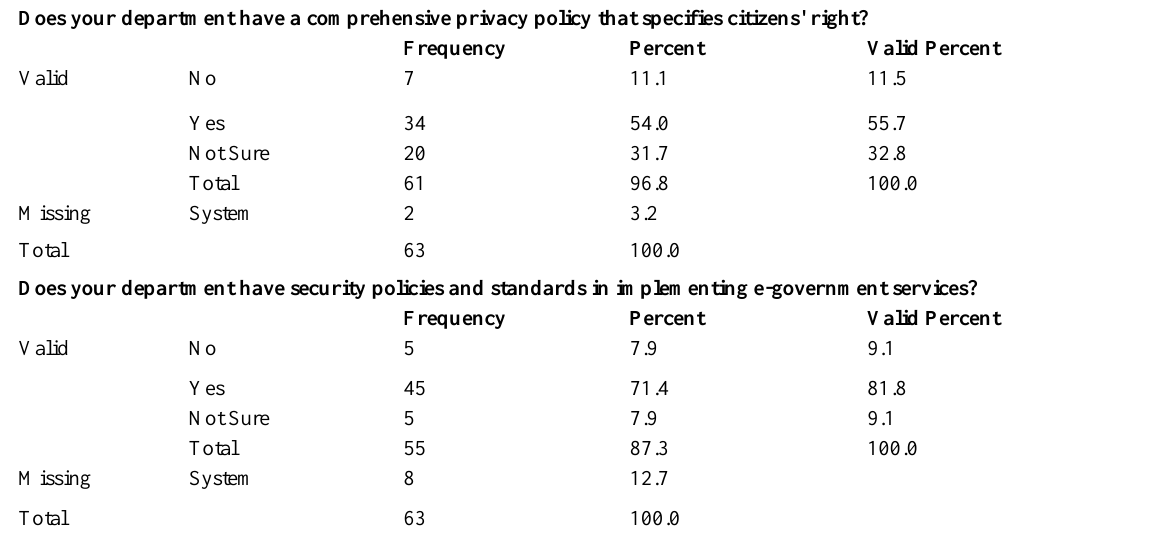
Table 13: Results of Questionnaire Processing Related to Privacy and Security Issue